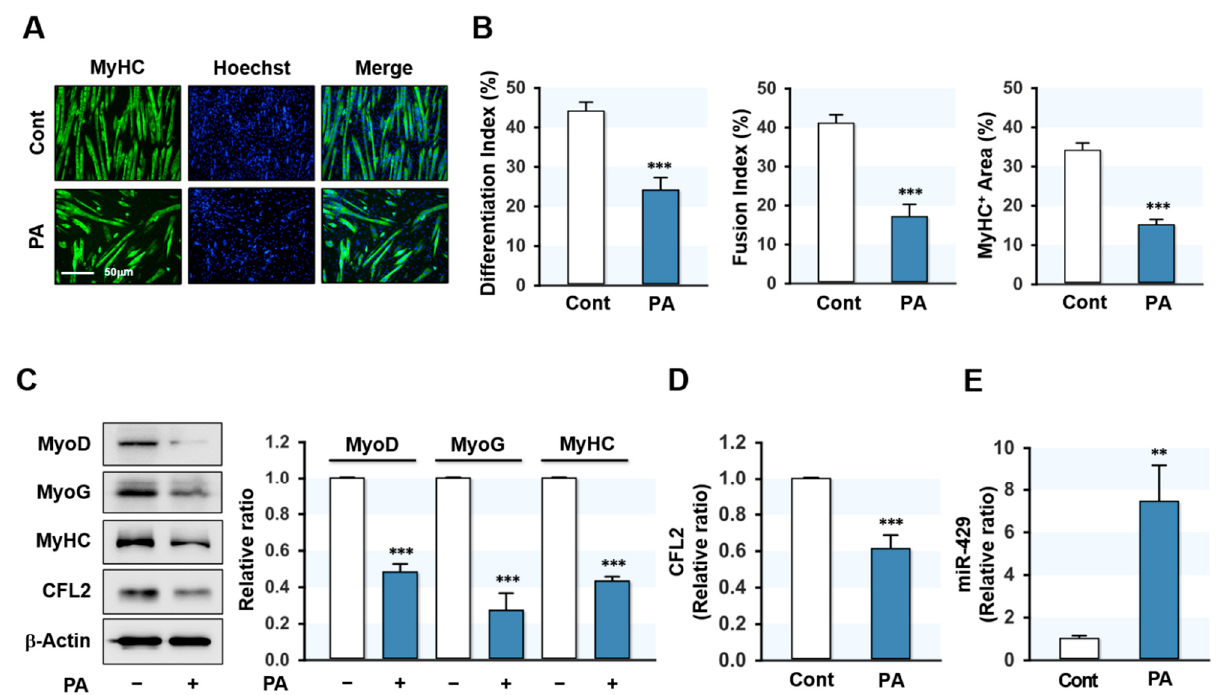
Figure 1. PA inhibited myoblast differentiation and induced miR-429-3p expression. To analyze the effect of PA on myogenic differentiation, C2C12 cells were allowed to differentiate for five days after treatment with PA (100 µ M, 24 h). ( A ) Immunocytochemistry staining with a MyHC (green) antibody. Hoechst (blue) was used to stain nuclei. Scale bar: 50 μ m. ( B ) The analysis of differentiation index, fusion index, and MyHC-positive area. ( C , D ) Immunoblot analysis of myogenic factors (MyoD, MyoG, and MyHC) and CFL2. β -Actin was used as a loading control. ( E ) q RT-PCR analysis of miR-429-3p expression. q RT-PCR and immunoblot results are shown as ratios vs. normal controls. All results are presented as means ± SEM ( n > 3), and levels of significance are presented as ** p < 0.01; *** p < 0.001 vs. controls.